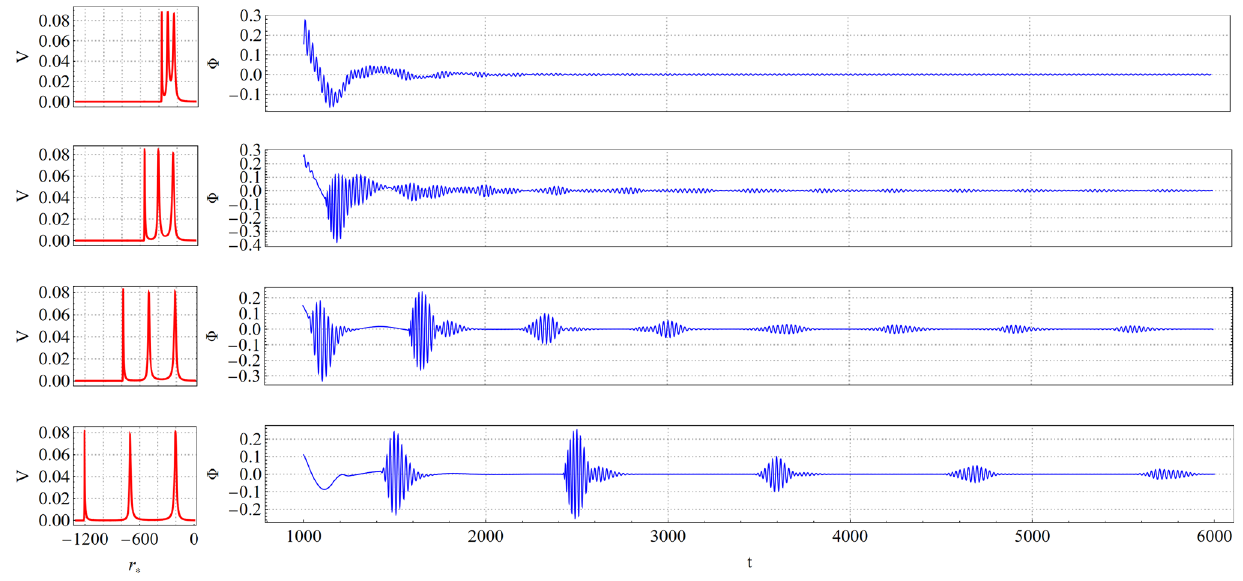
Fig. 4 The effective potential as a function of r ∗ and its correspond- ing time-domain profile. The parameters are M = 2 . 218 , c 2 = 5 . 194 , c 6 = − 4 . 459 , c 10 = 4 . 518 , c 14 = − 1 . 816 for the 1nd panel, M = 2 . 280 , c 2 = 5 . 408 , c 6 = − 4 . 677 , c 10 = 4 . 708 , c 14 = − 1 . 879